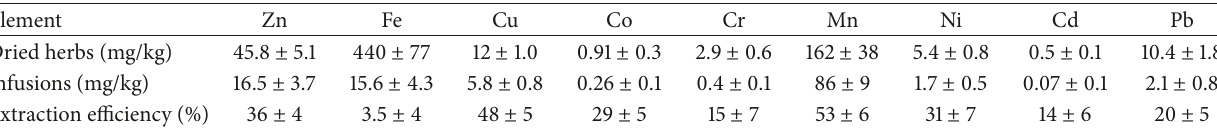
Table 4: Average contents of heavy metals (mg/kg) in the raw samples and water infusions of the medicinal herbs. Element Zn Fe Cu Co Cr Mn Pb Dried herbs (mg/kg) Infusions (mg/kg) Extraction efficiency